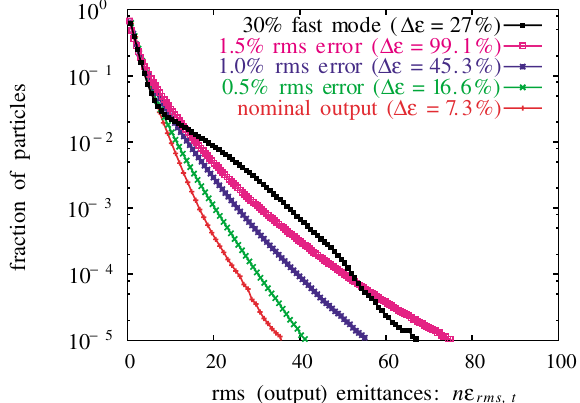
FIG. 13. (Color) Averaged fraction of particles exceeding n" for statistical error runs normalized to the final rms rms ;t emittance of each case. 500 simulations, 6D Gauss, 200 focus- ing periods, and (cid:25) " ! rms emittance growth.